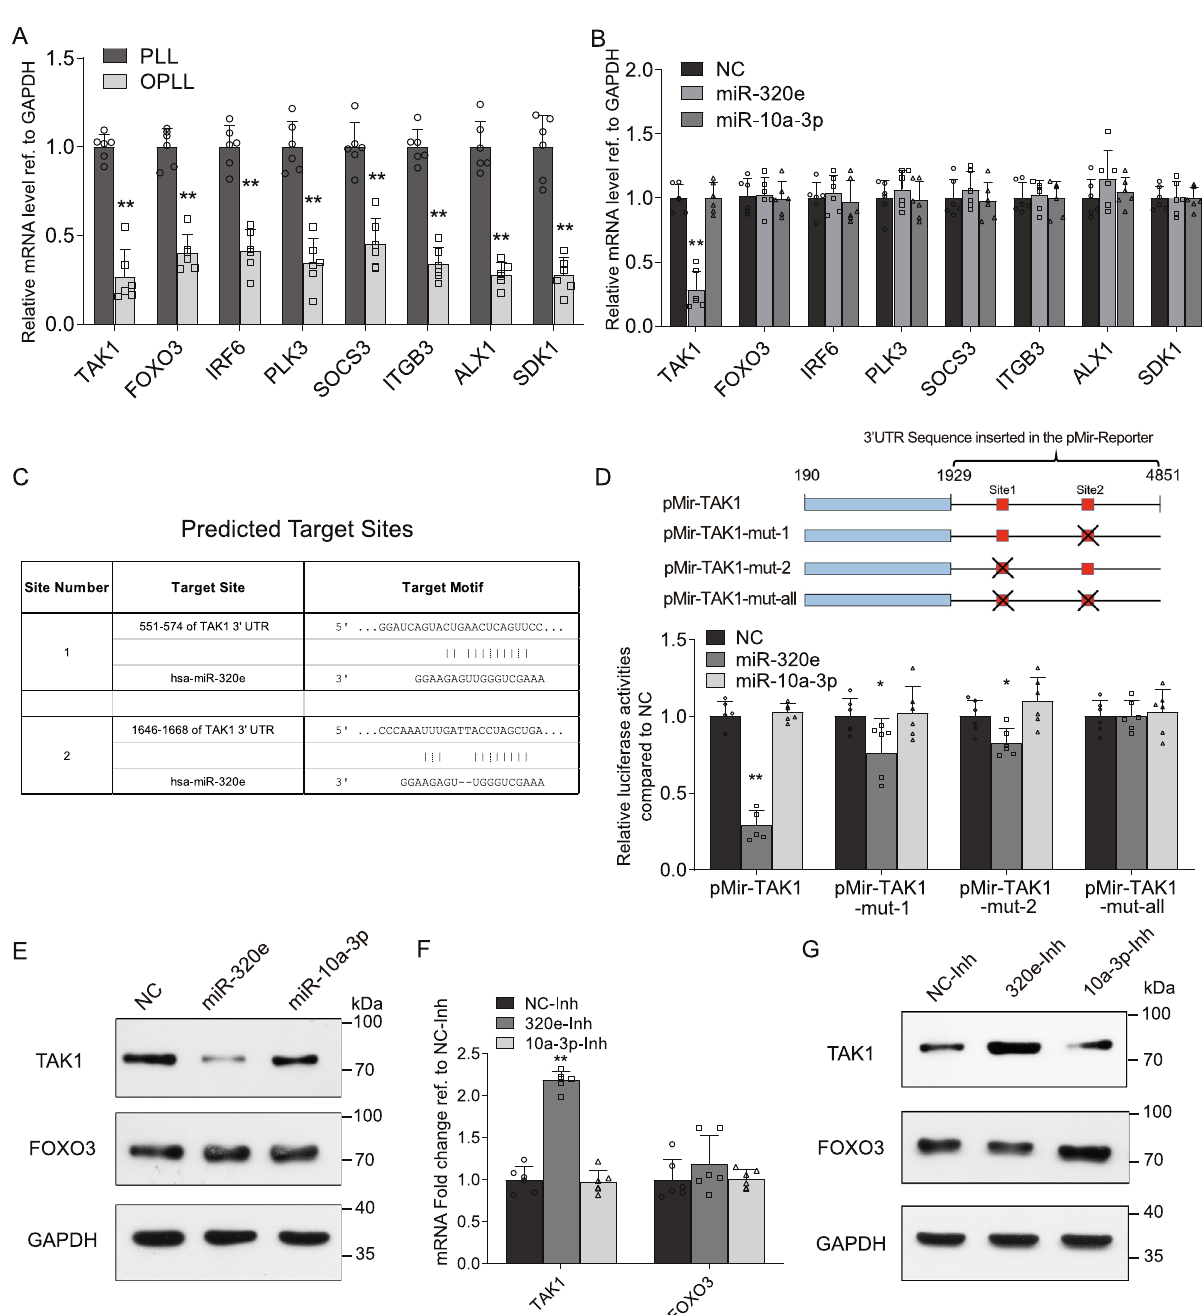
Fig. 6 TAK1 is targeted by miR-320e. A qRT-PCR analysis detecting the mRNA expression levels of miR-320e candidate targets in PLL and OPLL cells, n = 6, two tailed t test. B qRT-PCR analysis detecting the mRNA expression levels of miR-320e predicted targets after miR-320e or miR-10a-3p overexpression in PLL cells, n = 6, two tailed t test. Here miR-10a-3p is served as a negative miRNA control that are not correlated with the candidates. C MiRanda prediction of miR-320e binding motif in TAK1 3 ’ UTR. Note that the sites were picked according to the binding energy and rodent conservation. D Dual luciferase reporter assay detecting the activities of fi re fl y luciferase generated by respective 3 ’ UTR bearing plasmids after miR-320e or miR-10a-3p overexpression in HEK293T cells ( n = 6, two tailed t test). E Western Blot analysis showing the protein levels of TAK1 or FOXO3 after miR-320e or miR- 10a-3p overexpression in PLL cells. Here, FOXO3 is served as a negative target control, which miR-320e had no function on it, n = 3 biologically independent repeats with similar results. F mRNA levels of TAK1 and FOXO3 after miR-320e or miR-10a-3p inhibition in OPLL cells using qRT-PCR analysis, n = 6, two tailed t test. G Western Blot analysis showing the protein levels of TAK1 or FOXO3 after inhibition of miR-320e or miR-10a-3p in OPLL cells, n = 3 biologically independent repeats with similar results. GAPDH level were detected and served as internal reference. All data were presented as the mean ± SD. * p < 0.05, ** p < 0.01. Detailed statistical data and source data are provided in a Source Data fi